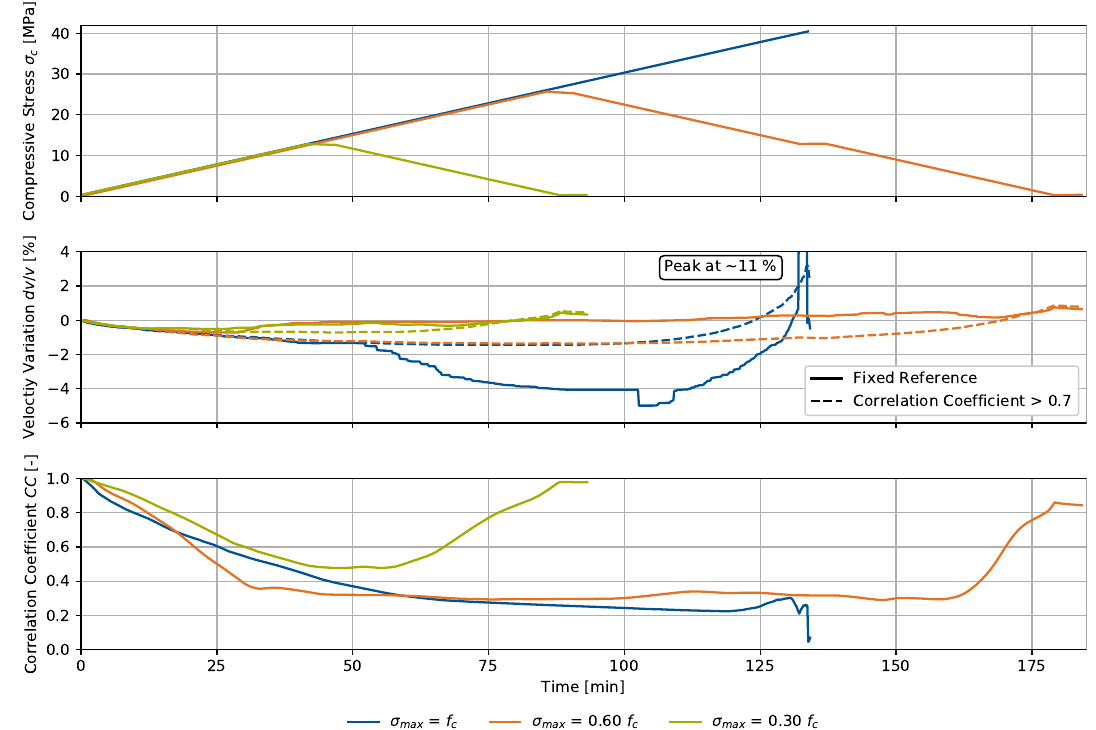
Figure 7. Uniaxial compression experiment for three specimens, referring to the setup in Figure 4 with different maximum stresses: compressive stress σ c , velocity variation dv / v and signal correlation coefficient CC over